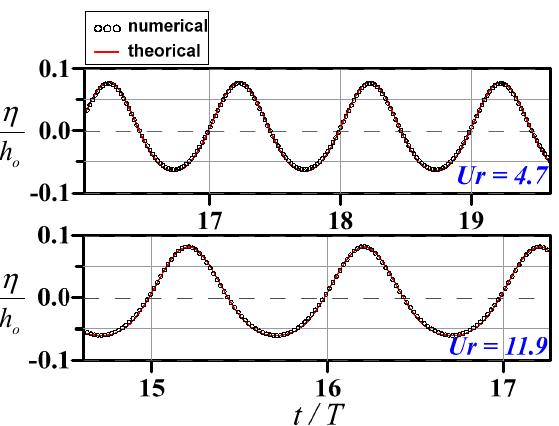
Figure 7. Comparison of periodic wave forms generated by the present numerical wave tank with that obtained from the theoretical solutions. ( ○ ) Numerical results from the proposed model; (-) theoretical solutions.